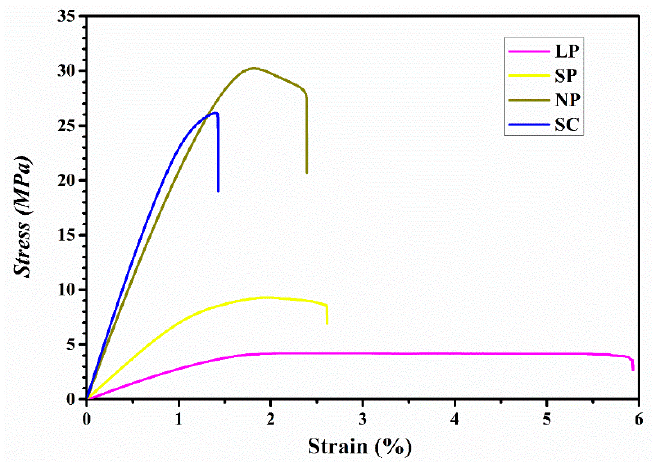
Figure 3. Representative stress-strain curves of the tensile tests performed on LP, SP, NP, and SC membranes.